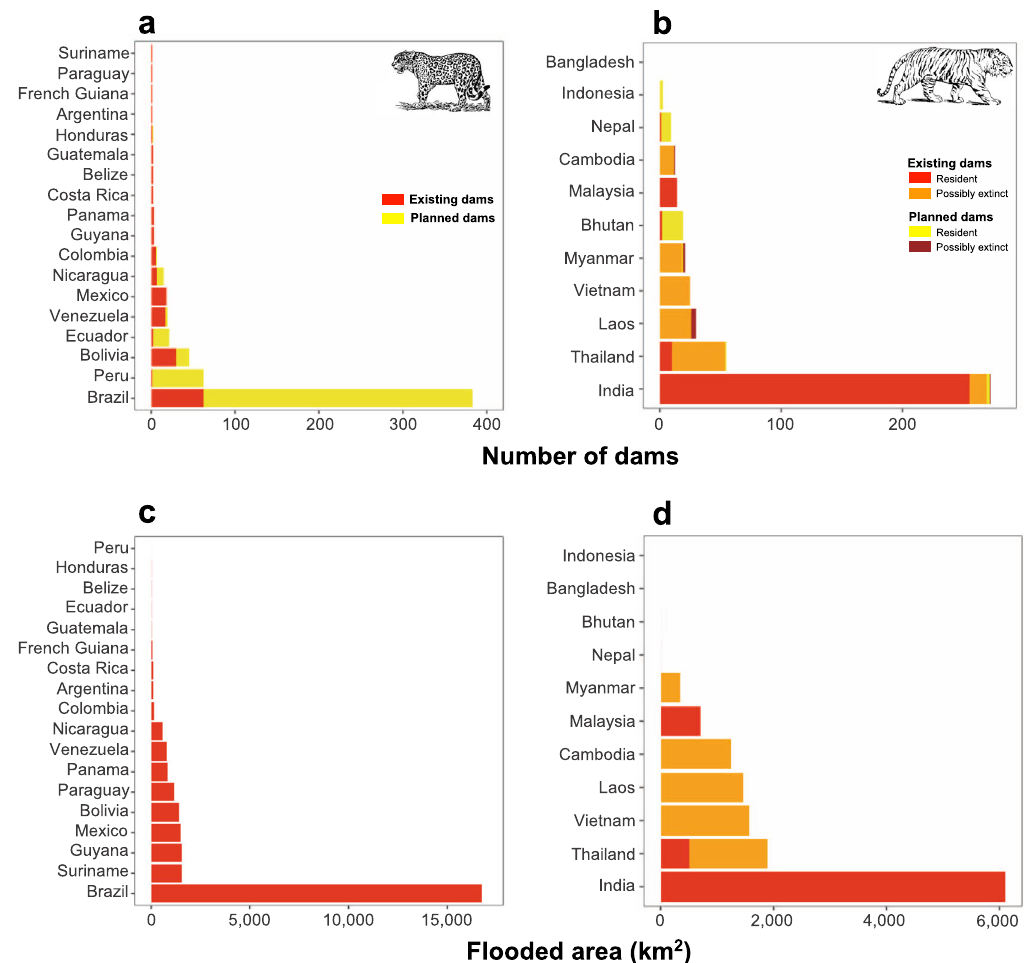
Fig. 2 Number and fl ooded areas of existing and planned hydropower dams intersecting jaguar and tiger distributions by country. a Number of existing and planned dams intersecting the jaguar distribution. b Number of existing and planned dams intersecting the tiger distribution. c Area fl ooded by hydropower reservoirs intersecting the jaguar distribution. d Area fl ooded by hydropower reservoirs intersecting the tiger distribution. Existing and planned dams are shown in red and yellow, respectively. For tigers, additional colors were used for dams located in areas where tigers are possibly extinct (existing: orange, planned: maroon). Panels c and d include only existing dams. Source data for all dams can be found in Supplementary Table